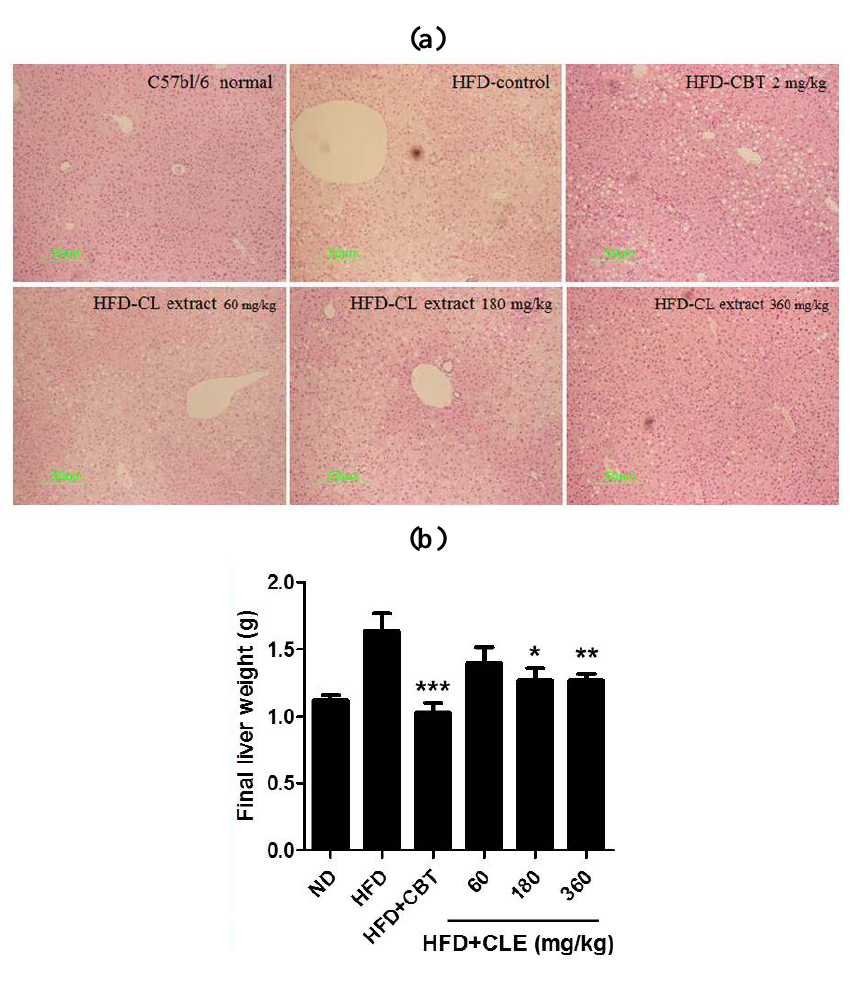
Figure 6. Effect of CLE on hepatic steatosis in HFD-fed mice. ( a ) Representative sections of liver tissue stained with hematoxylin and eosin (H & E). ( b ) Effect of CLE on liver weight in HFD-fed mice. Values are the mean ± SEM ( n = 10), * p < 0.05, ** p < 0.01, *** p < 0.001 vs. HFD-fed